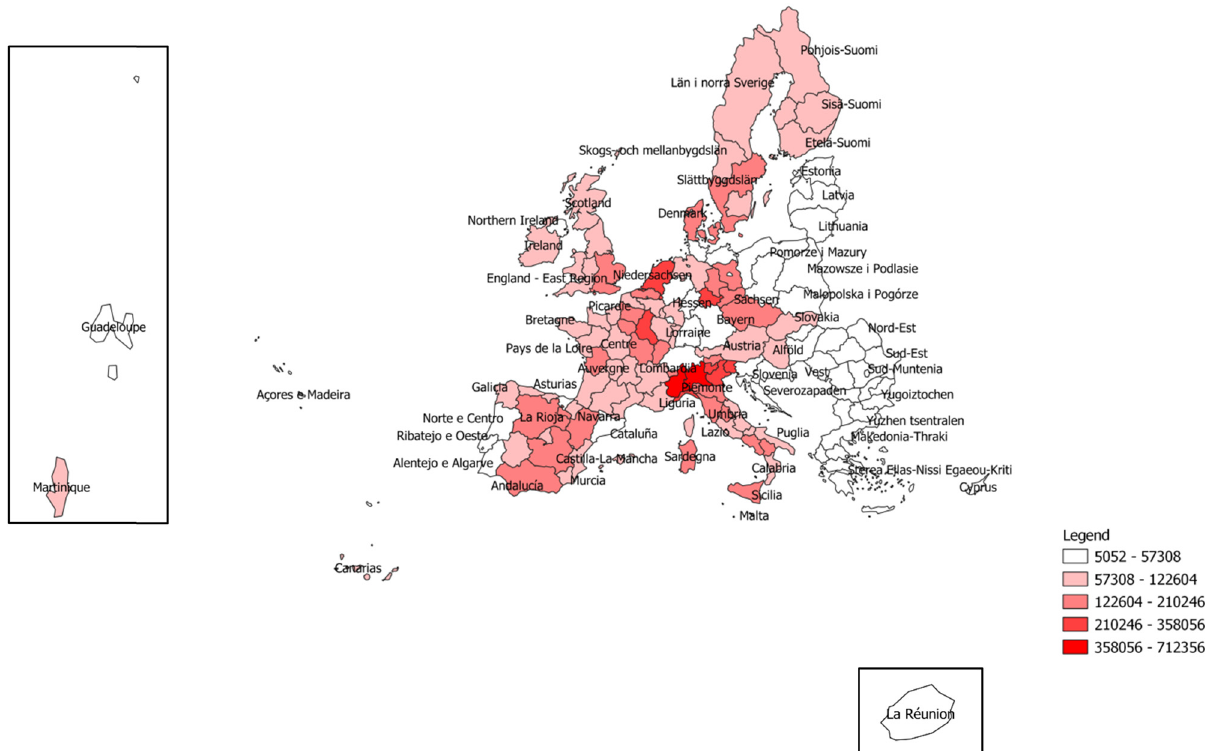
Figure 1: Distribution of the net working capital ( euros ) across the former 28 European Union agricultural regions, on average over the period 2016 – 2018. Source of the original shape fi le: [ 9 ]